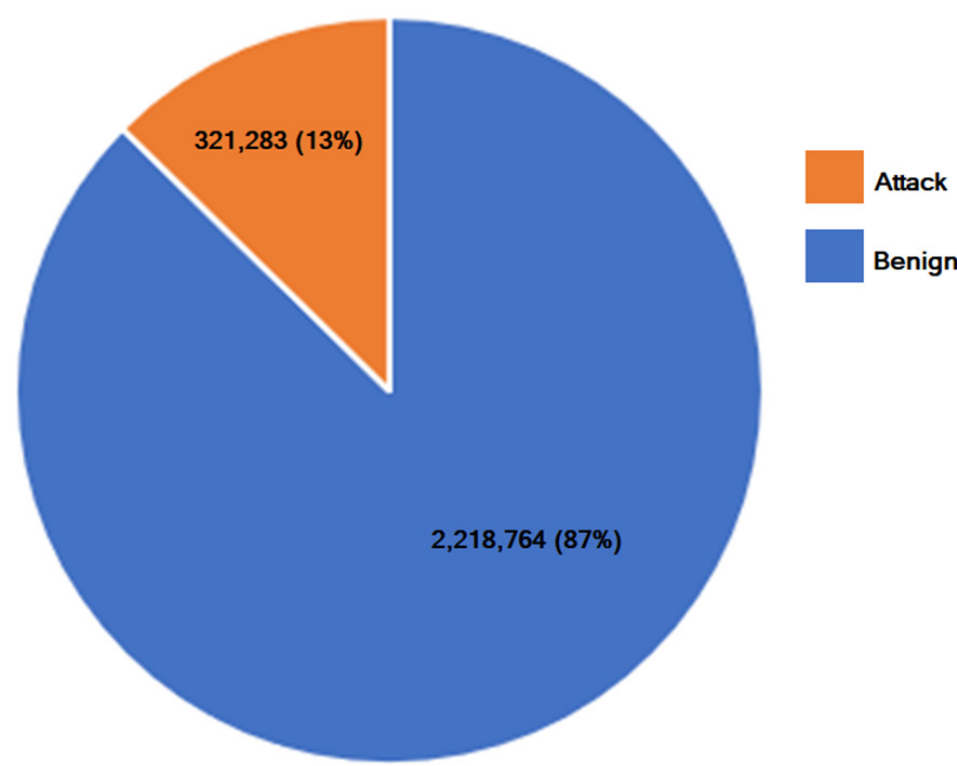
Figure 2. Distribution of Benign versus Attacks.